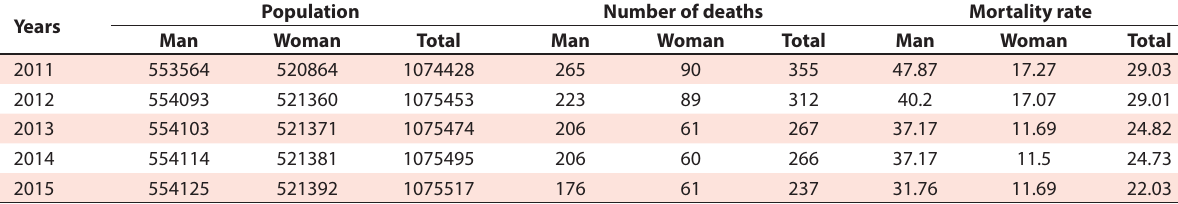
Table 1. The incidence mortality rate of road traffic accidents in Yazd province per 100 000 populations during 2011-2015 Population Number of deaths Mortality Years